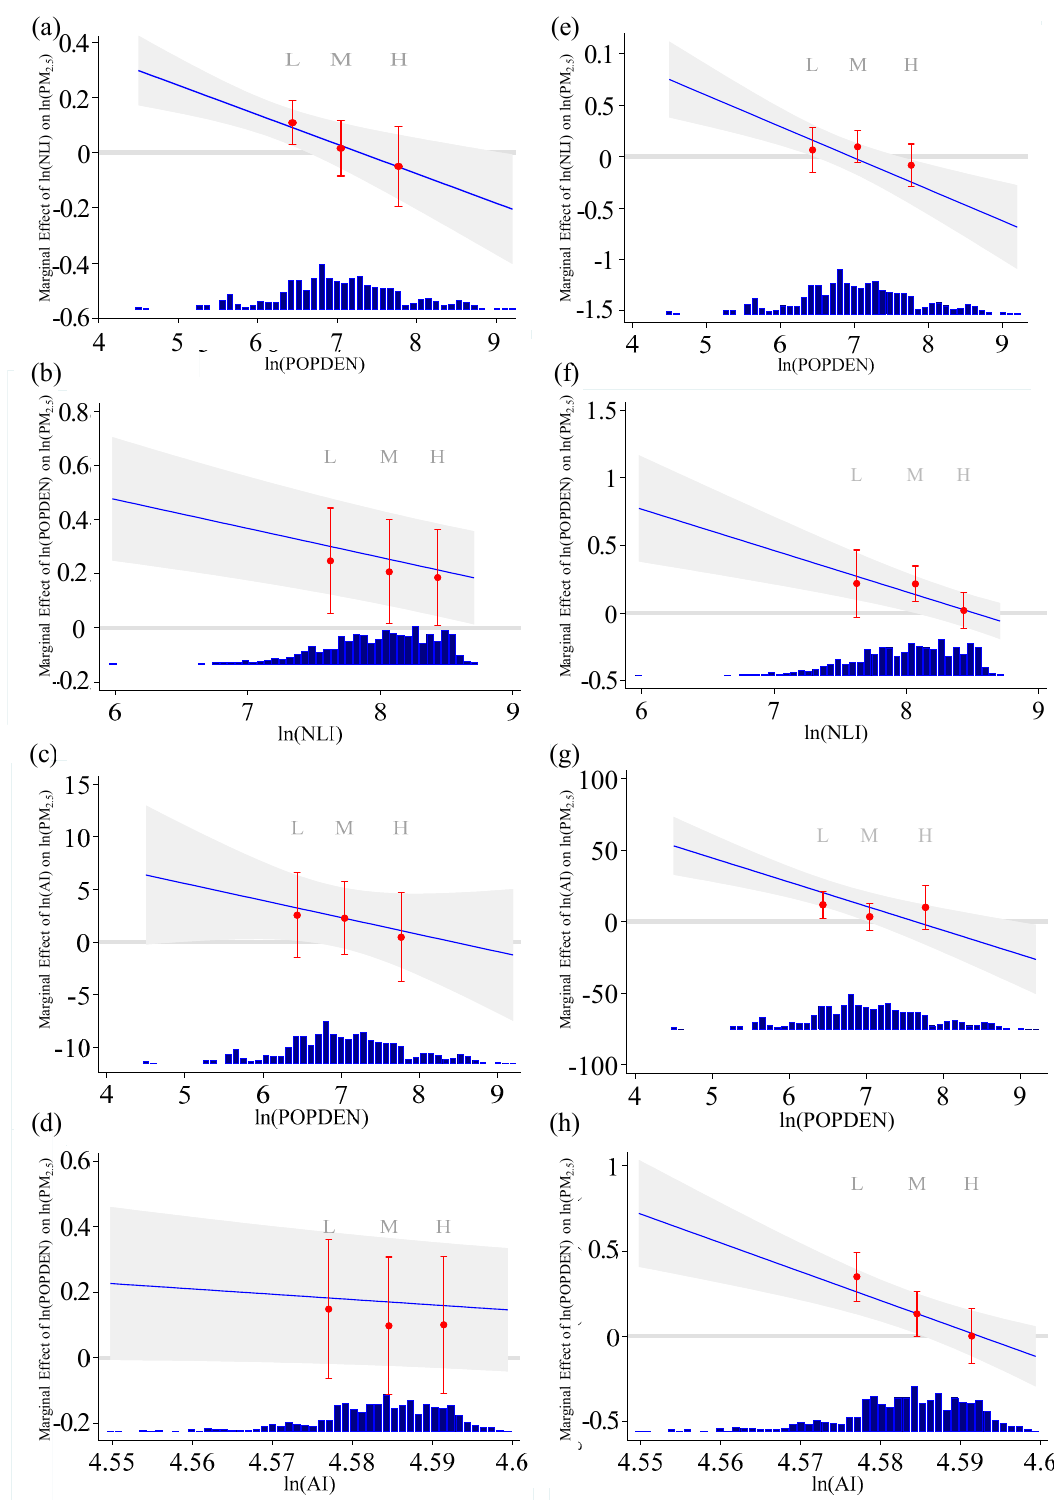
Figure 7. Linear interaction diagnostic plots. The above plots examine the marginal effects plot, marginal effects estimate from the model (blue line) and the binning estimator (red dots). H, M, and L represent subgroups with high-, medium-, and low-level indicators, respectively. ( a – d ) illustrate the interactions in the FE model, while ( e – h ) illustrate the interactions in the pooled sectional model.